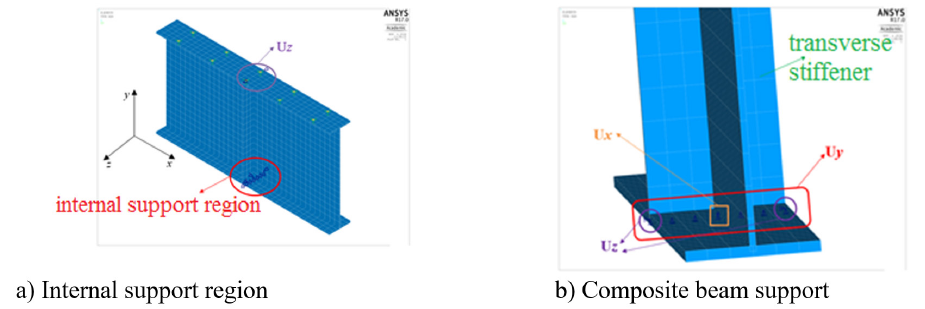
Figure 4. Boundary conditions of numerical models.